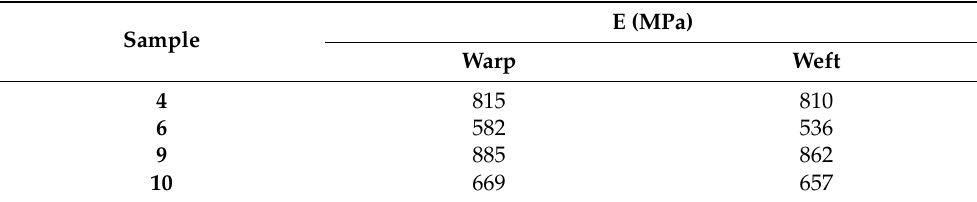
Table 4. The obtained Young’s modulus values .